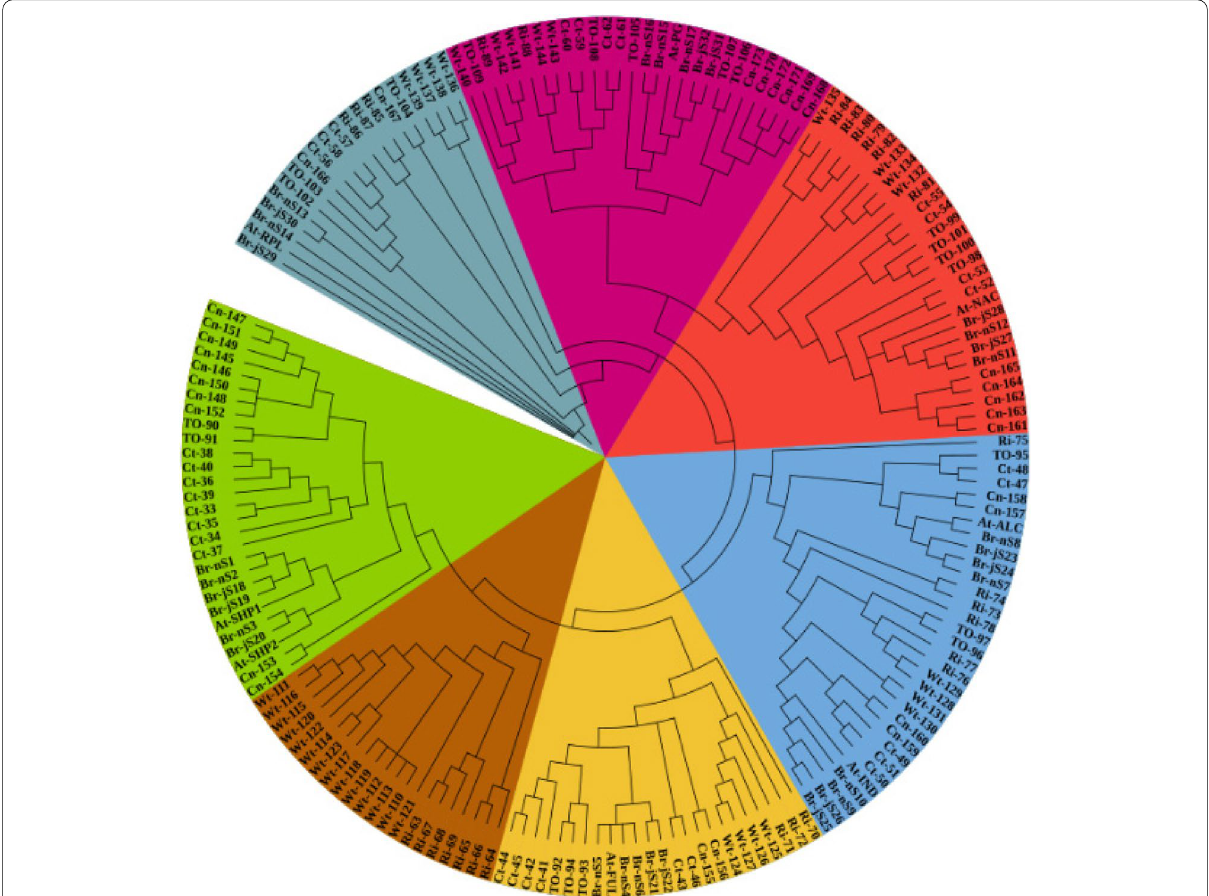
Fig. 1 Neighbor joining consensus phylogenetic tree of 181 shattering genes from B. napus (17), B. juncea (15), Arabidopsis (At 8), citrus (Ct 30), cotton (Cn 29), rice (Ri 27), wheat (Wt 35), and tomato (TO